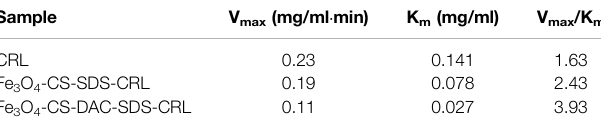
TABLE 2 | Kinetic parameters of immobilized